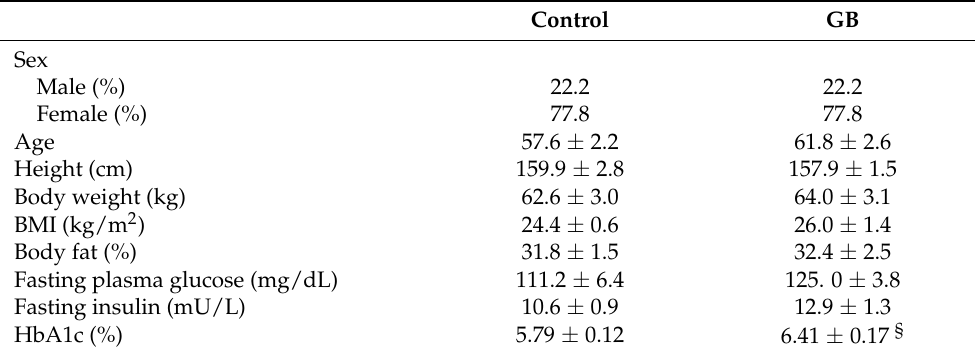
Table 1. Baseline subject characteristics.